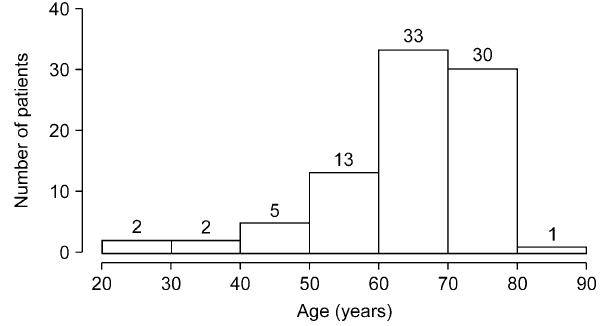
Figure 1. Age at the diagnosis of cytomegalovirus gastroenterocolitis in immunocompetent